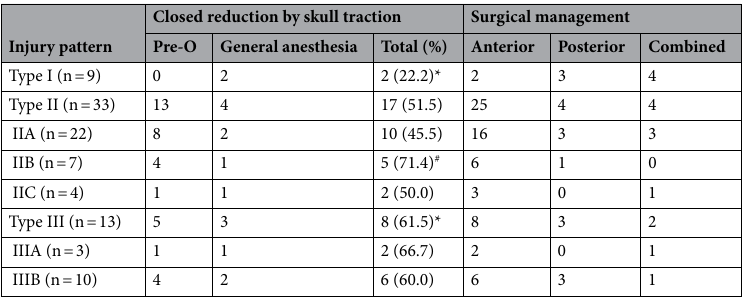
Table 5. The management of each type or subtype patients with UCLF. *Indicates a significant difference among the three types of UCLF based on the Chi-square test, p < 0.05. # Indicates a significant difference among the three subtypes of type II based on the Fisher exact test, p < 0.05.